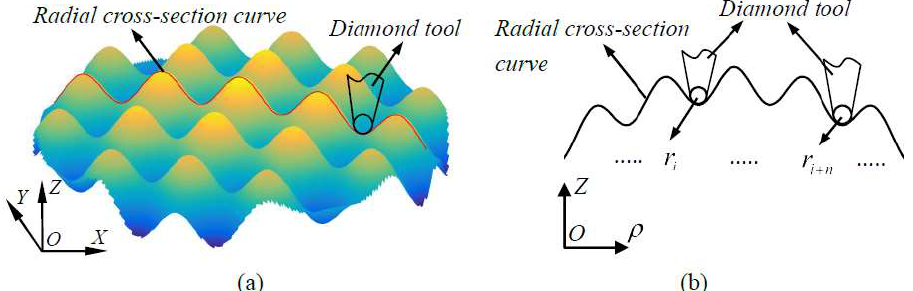
Figure 11. Illustration of geometry between tool nose radius and radial cross-section curve. ( a ) The surface radial curve for tool nose radius optimum; ( b ) Geometry relation between tool nose radius and surface radial curve curvature radius.